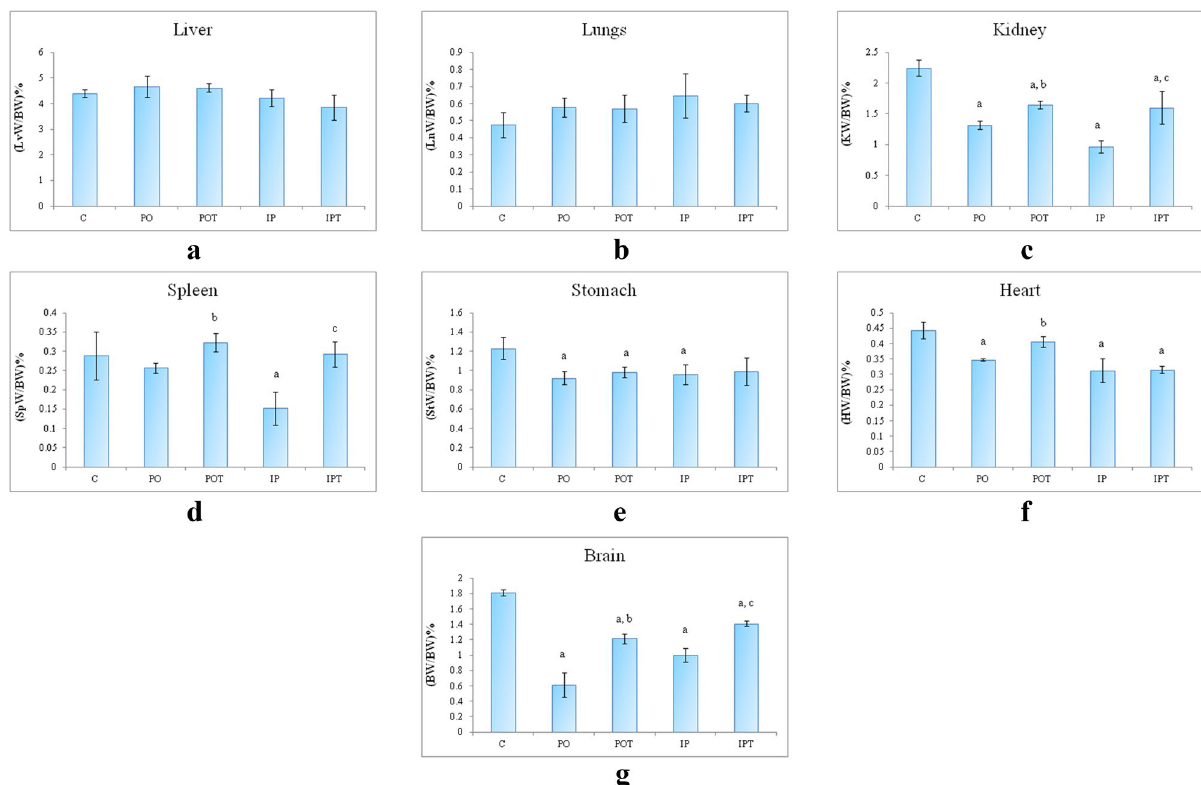
Figure 2. Relative organ: body weight ratio of ( a ) liver, (LvW/BW is weight of liver/body weight)%, ( b ) lungs, (LnW/BW is weight of lungs/body weight)%, ( c ) kidney, (KW/BW is weight of kidneys/body weight)%, ( d ) spleen, (SpW/BW is weight of spleen/body weight)%, ( e ) stomach, (StW/BW is weight of stomach/body weight)%, ( f ) heart, (HW/BW is weight of heart/body weight)%, ( g ) brain, (BW/BW is weight of brain/body weight)%. The results are shown in mean ± SE (‘a’ represents p < 0.005 control vs experimental groups, ‘b’ represents p < 0.005 experimental vs treatment groups (PO vs POT) and ‘c’ symbolizes p < 0.005 IP vs IPT). The x-axis comprises of the different groups—control (C), oral toxin (PO), oral toxin and oral Cin treatment (POT), intra-peritoneal toxin (IP), intra-peritoneal toxin and oral Cin treatment